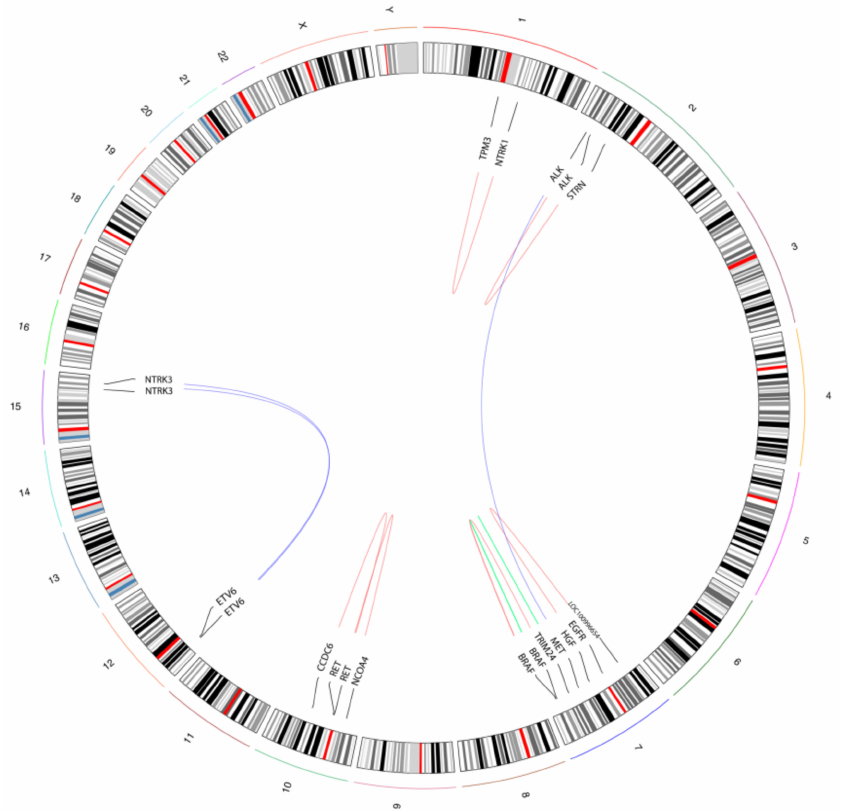
Figure 2. Schematic illustration of the detected gene fusions and rearrangements. The circos plot sum- marizes the fusion events identified in the “real-world” cohort. The curved lines show partner genes, with blue lines representing inter-chromosomal fusions, red lines indicating intra-chromosomal fusion between different genes, and green lines representing intra-chromosomal rearrangements within the same